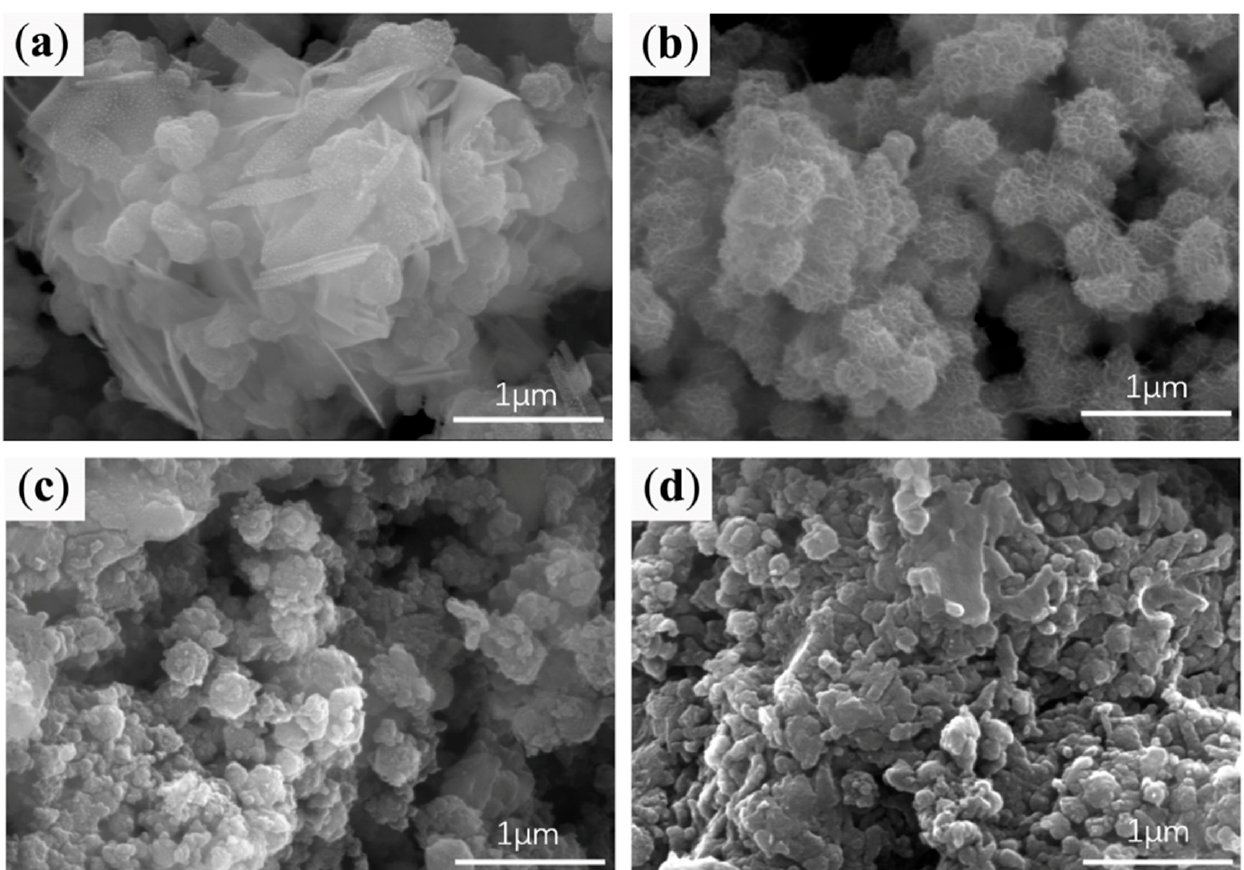
Figure 2. SEM images of polyaniline (PANI)/MnO 2 composite ( a ) PANI/MnO 2 -40, ( b ) PANI/MnO 2 -50, ( c ) PANI/MnO 2 -60, ( d ) PANI/MnO 2 -70.